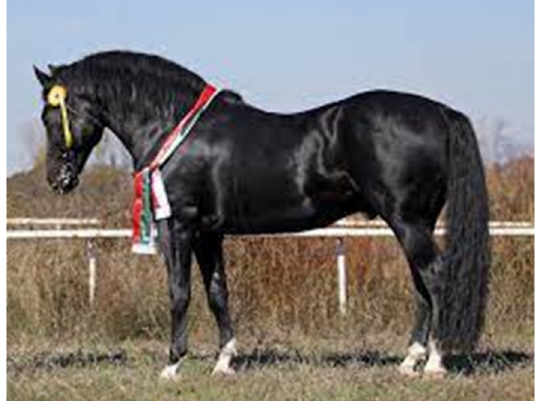
Figure 1. A typical representative of the Danubian horse breed (photo by Georgi Yordanov). This horse was officially recognized as a breed in 1951 [13]. The Danubian horse was created in the Klementina stud farm in the village of Pobeda (Pleven region). The basis of the tribal nucleus was stallions and mares of the breed Nonius, imported from Hungary (from the Mezohegyes stud farm) and also from the former Republic of Yugoslavia and the Czechoslovak Republic in 1956 (Figure 2) [13]. From the beginning, purebred breeding of the imported stallions and mares from the Nonius breed was applied [14].